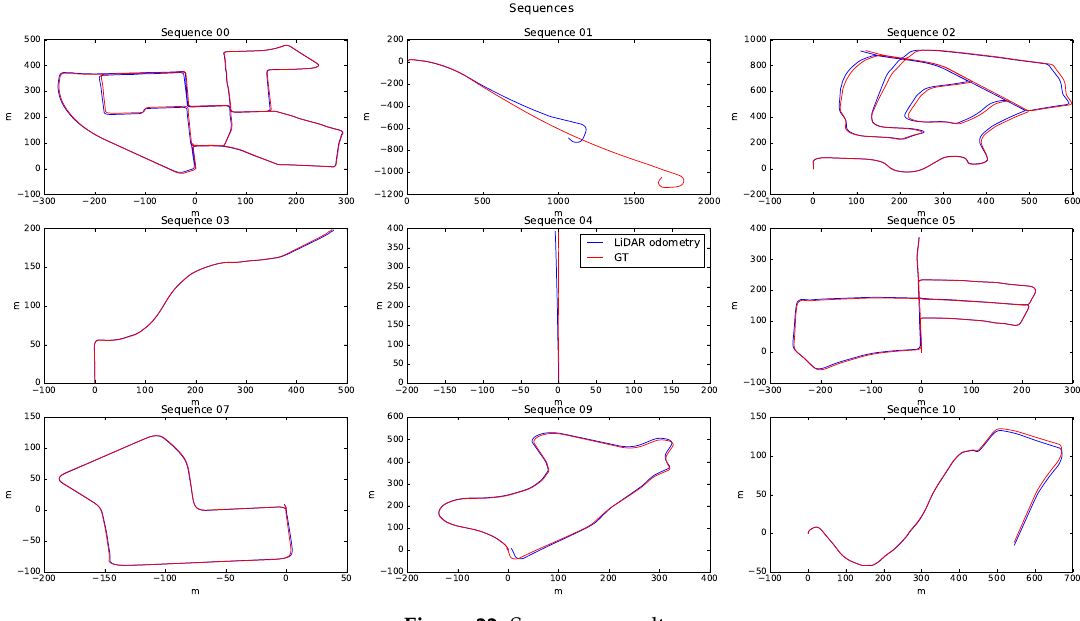
Figure 22. Sequence